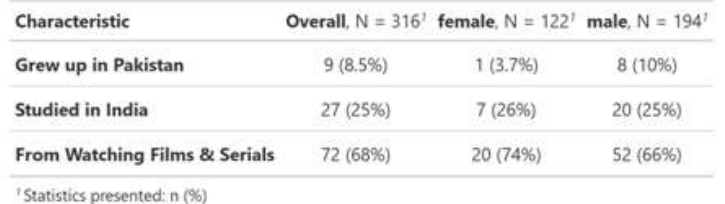
Table 16: How did you learn Urdu/Hindi/Hindustani language? (Source: Authors‟ depiction )